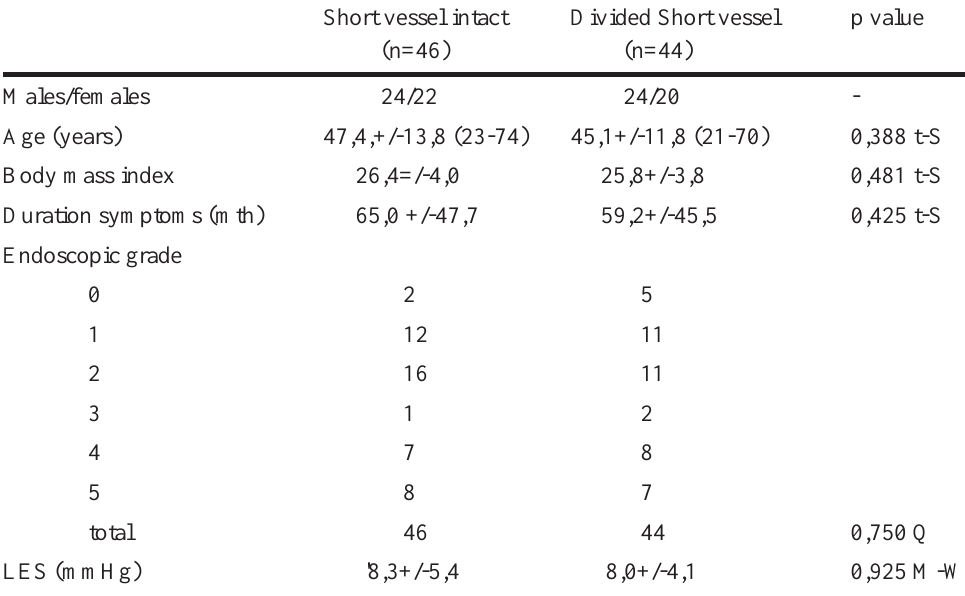
TABLE 1 - Characteristics of patients enrolled in the